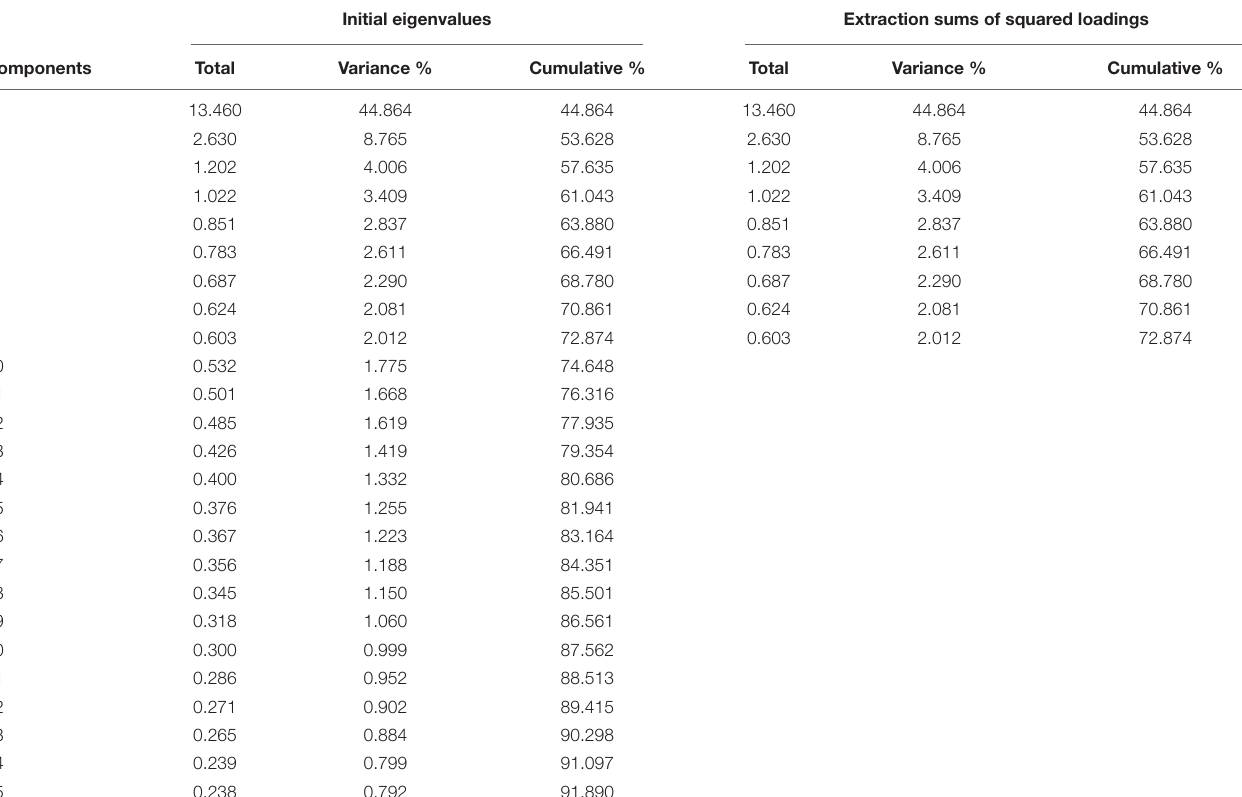
TABLE 8 | Total variance